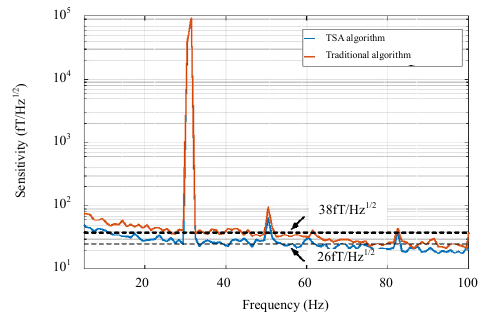
Fig. 7 Using the measured value as the compensation value, the measurement sensitivity of TSA is 26 fT/Hz 1/2 , which is superior compared with the 38 fT/Hz 1/2 of the conventional